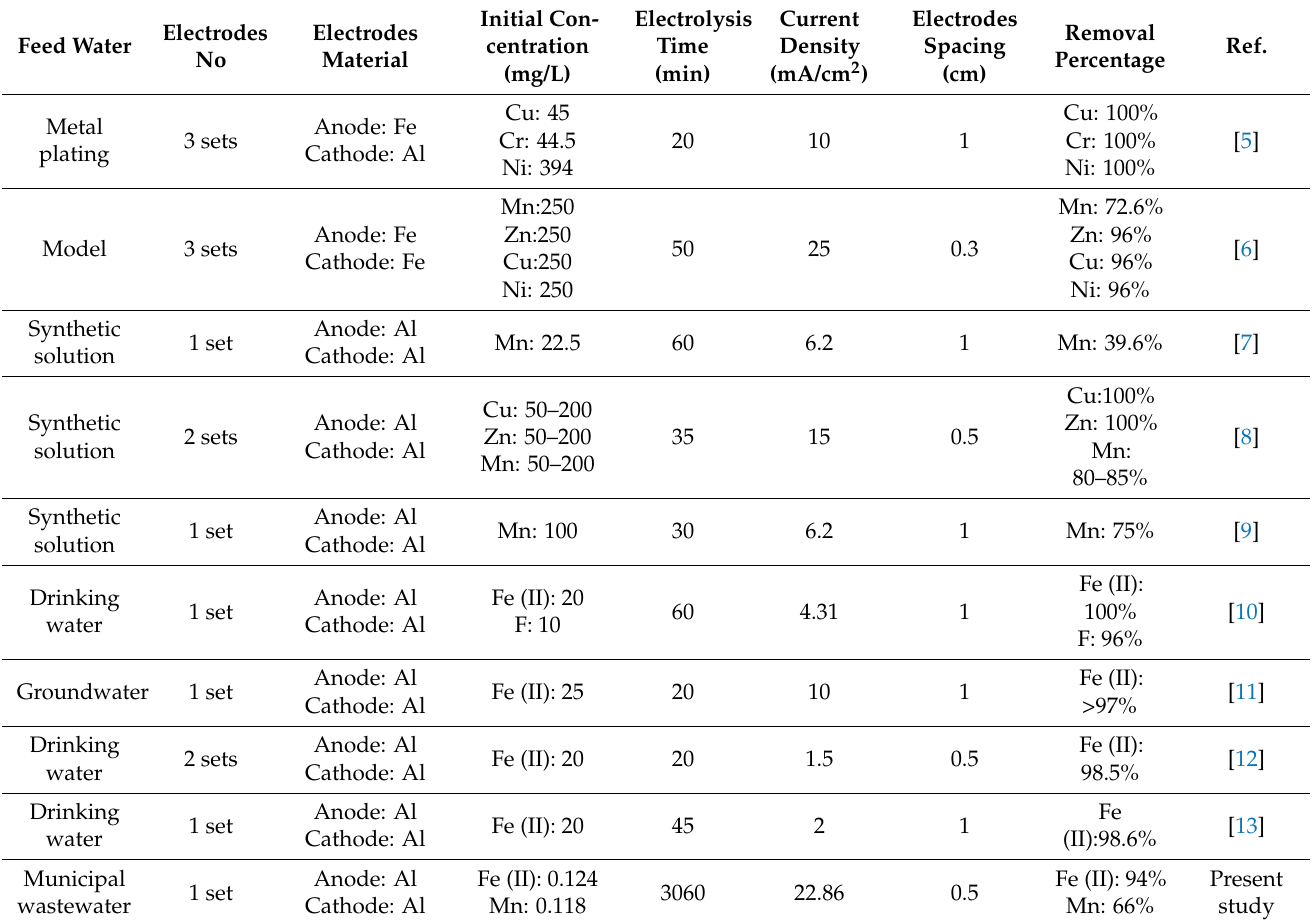
Table 1. Previous studies and the present study on the removal of heavy metals using the electrocoagulation process and electrocoagulation-enhanced dielectrophoresis,